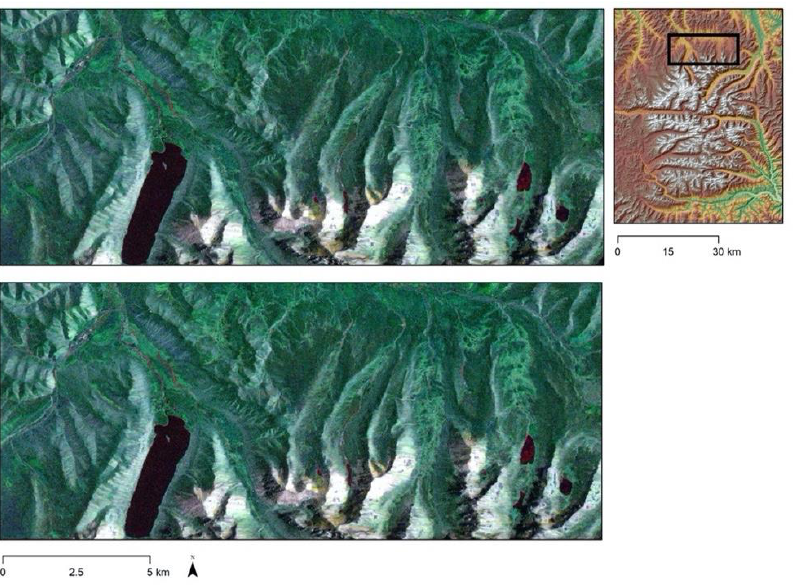
Figure 6. False color Sentinel-1 VV image showing distinctive seasonal hydrological and vegetation patterns of wetlands compared with the surrounding grassland in 2019 ( top ) and 2010 ( bottom ).